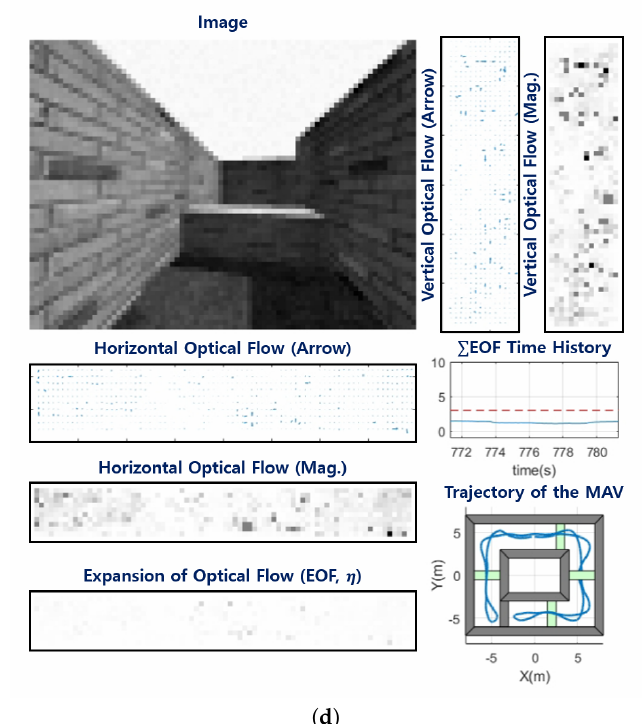
Figure 11. Simulation results for the hybrid obstacle avoidance strategy: ( a ) t = 50 s; ( b ) t = 241 s; ( c ) t = 558 s; and ( d ) t = 781